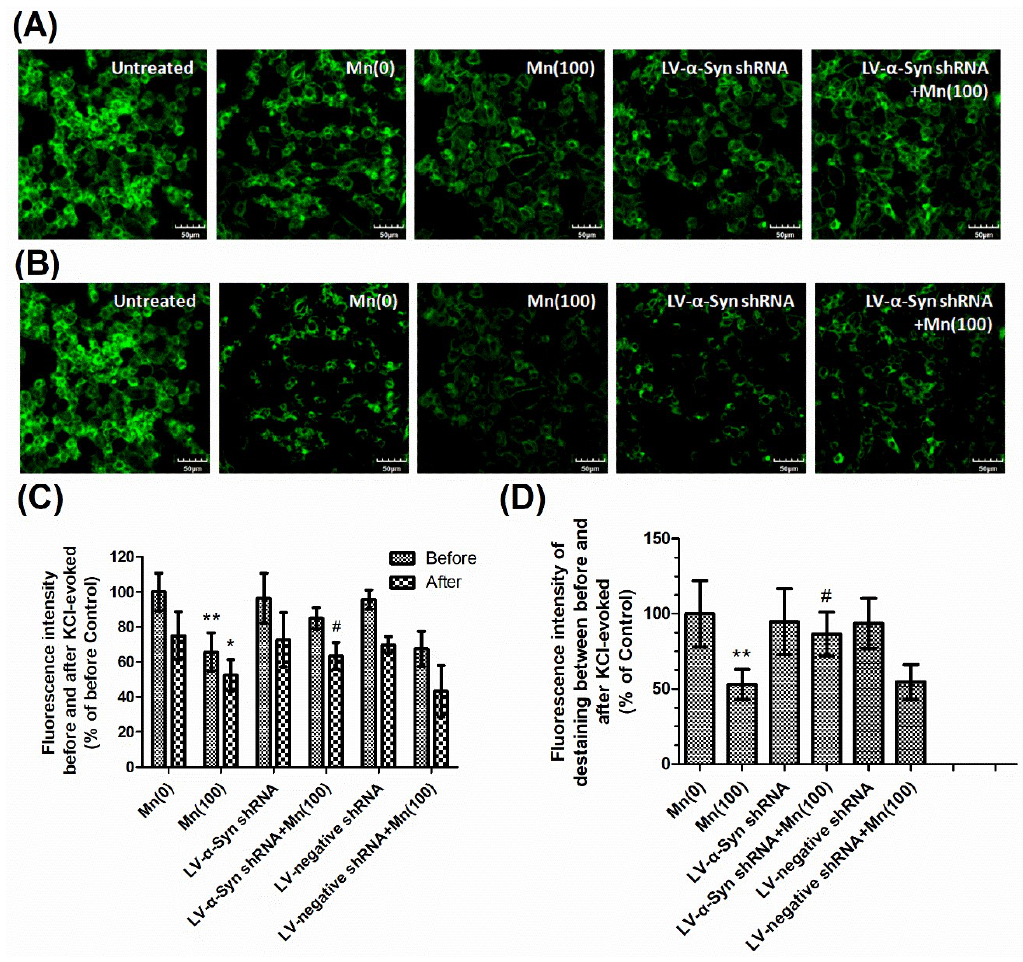
Figure 6. α -Syn shRNA promoted KCl-evoked synaptic vesicle fusion during Mn exposure. After treatment with different doses of Mn, cells were incubated with 100 µ M FM1-43 for 2 min in HBM containing 1mM Ca 2+ and 30 mM K + . ( A ) The FM1-43 fluorescence before KCl-evoked exocytosis. ( B ) The FM1-43 fluorescence 30 min after 15 mM KCl-evoked exocytosis. Untreated sample represented the normal downloading of the fluorescent dye in neurons neither KCl-evoked nor Mn-treated. ( C ) Fluorescence intensity before and after KCl-evoked exocytosis in different groups normalized with those of controls. ( D ) Relative fluorescence intensity between ( A ) and ( B ) in different groups normalized with those of controls. Data represent mean ± standard deviation, n = 4. * p < 0.05 and ** p < 0.01 indicates significant differences from controls; # p < 0.05 indicates significant differences from the 100 µ M Mn-treated group. Scale bars: 50 μm.